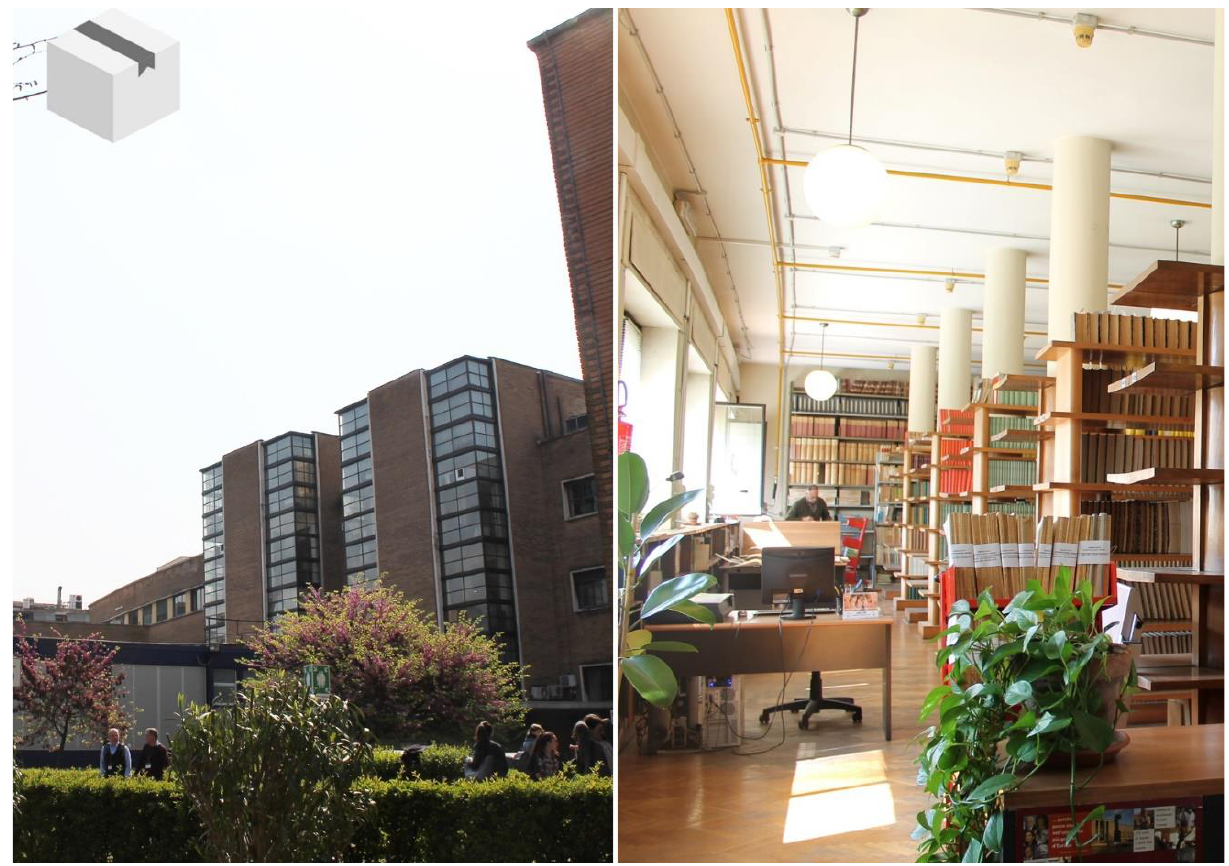
Figure 6. The Botany Institute.